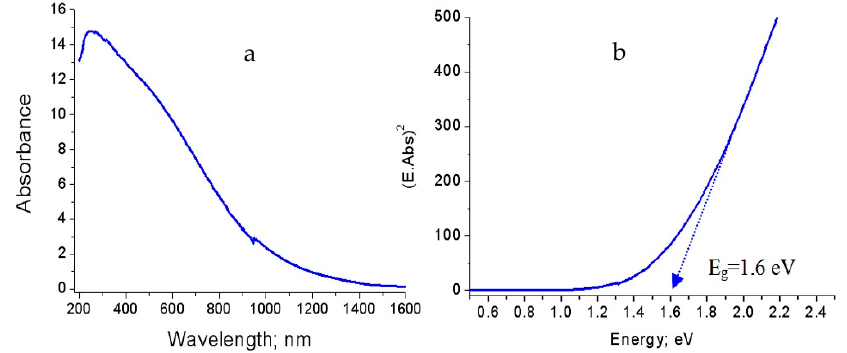
Figure 10. The prepared nanocomposite NC-2: ( a ) Absorbance spectrum and ( b ) Band gap energy.